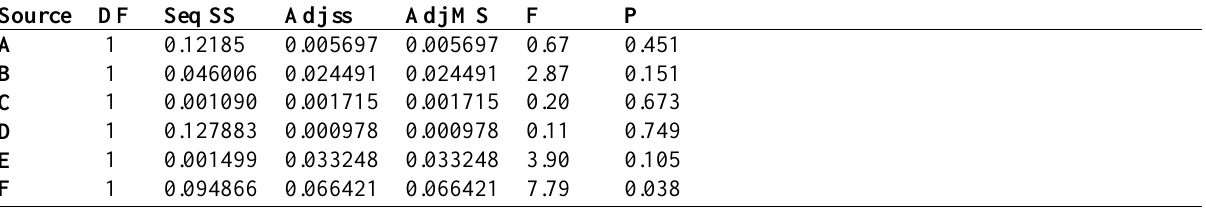
Analysis of variance for S/N